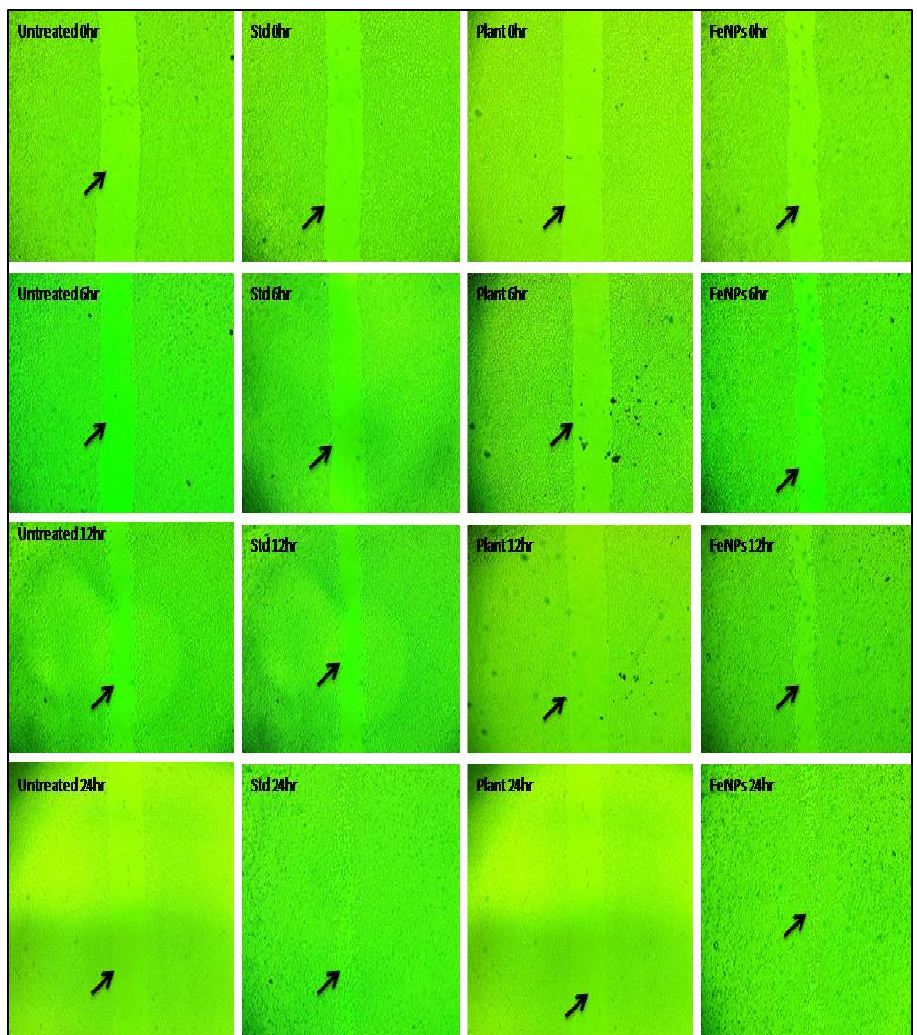
Figure 17. Morphological wound closure studies of V. leucoxylon and its synthesized iron nanoparticle. Arrows indicate cell migration for wound healing.